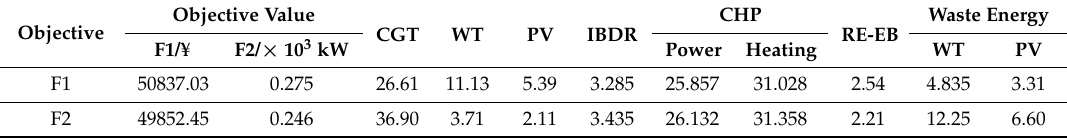
Table 1 Scheduling results of hybrid energy system (HES) operation for different objective functions.